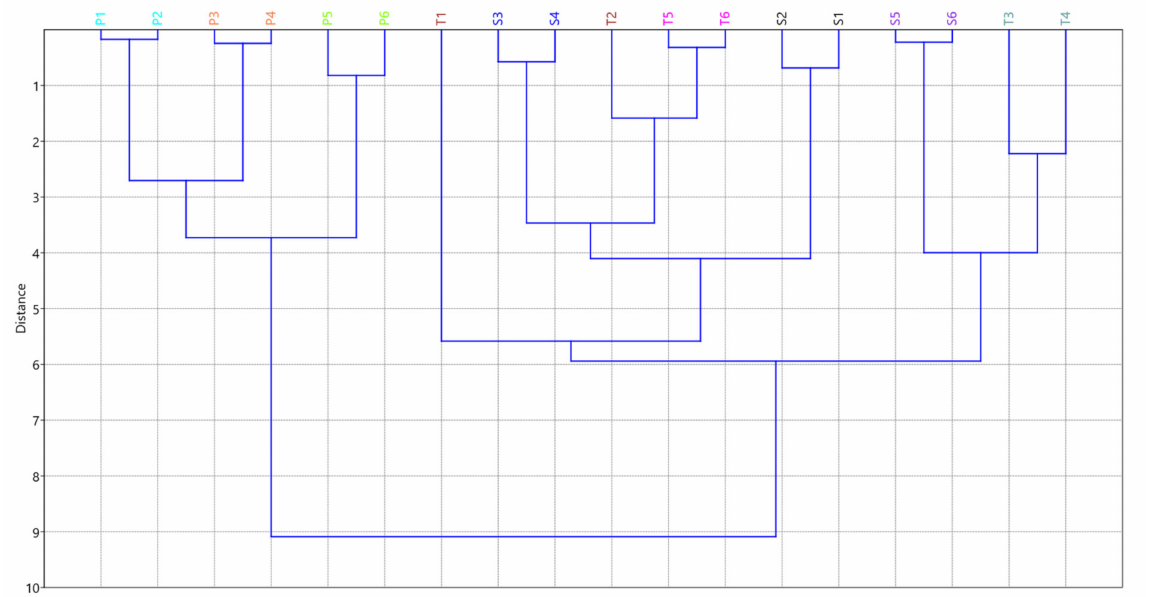
Figure 10. Hierarchical clustering plot showing the correlation between the different M. whitei product